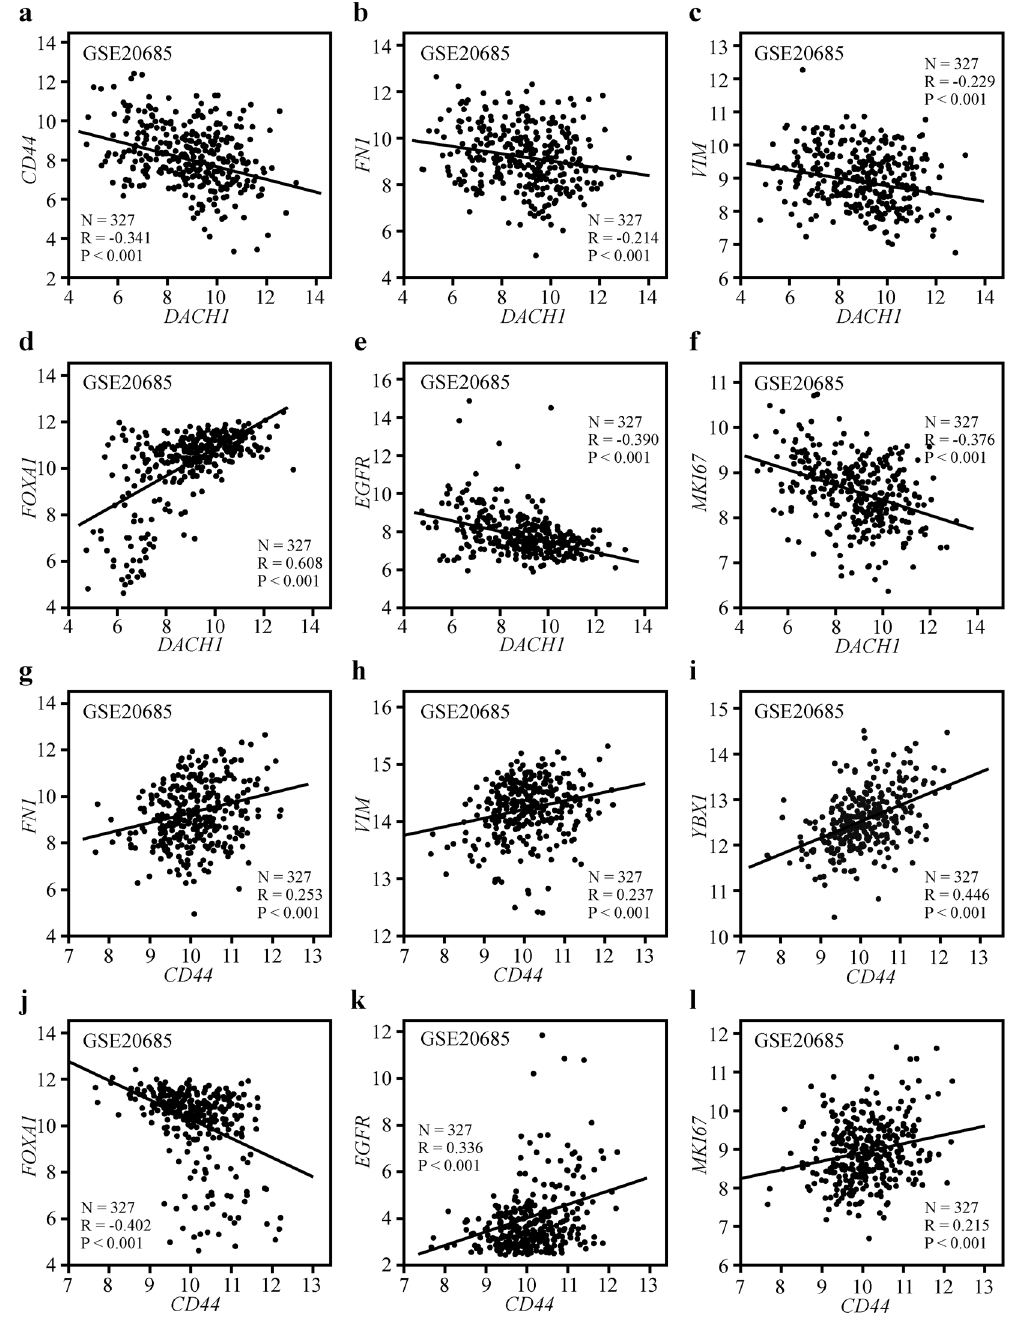
Figure 5. The expression of DACH1 and CD44 correlated with VIM , FN1 , YBX1 , FOXA1 , EGFR and MKI67 in breast cancer tissues. Correlation analysis of public dataset GSE 20685 showed that DACH1 was inversely correlated with cancer stem cell marker CD44 ( a ), mesenchymal markers FN1 ( b ) and VIM ( c ) as well as basal-like markers EGFR ( e ) and MKI67 ( f ), while positively associated with luminal marker FOXA1 ( d ). CD44 was parallel with FN1 ( g ) and VIM ( h ), YBX1 ( i ), EGFR ( k ) and MKI67 ( l ), while negatively associated with FOXA1 ( j